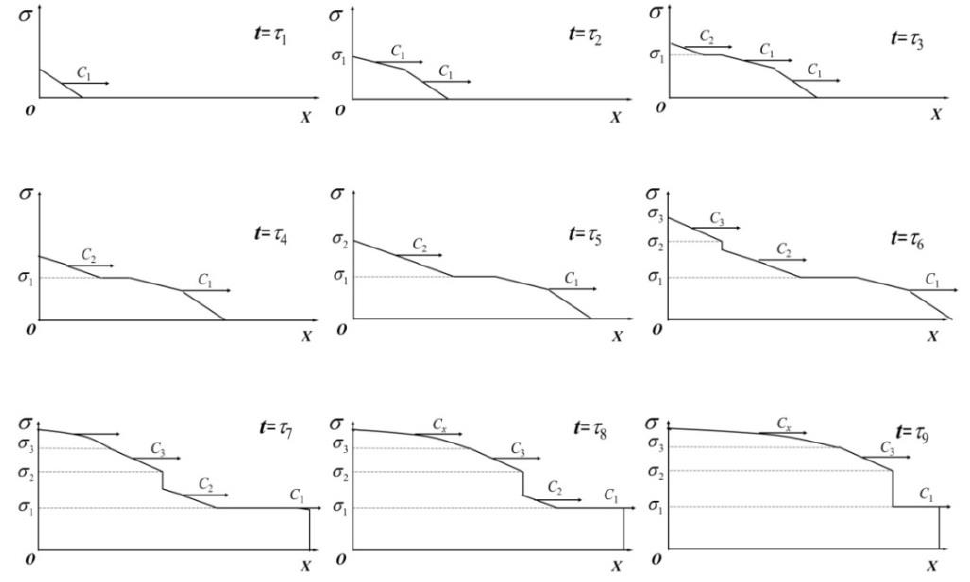
Figure 9. Stress profiles under some instantaneous stages.